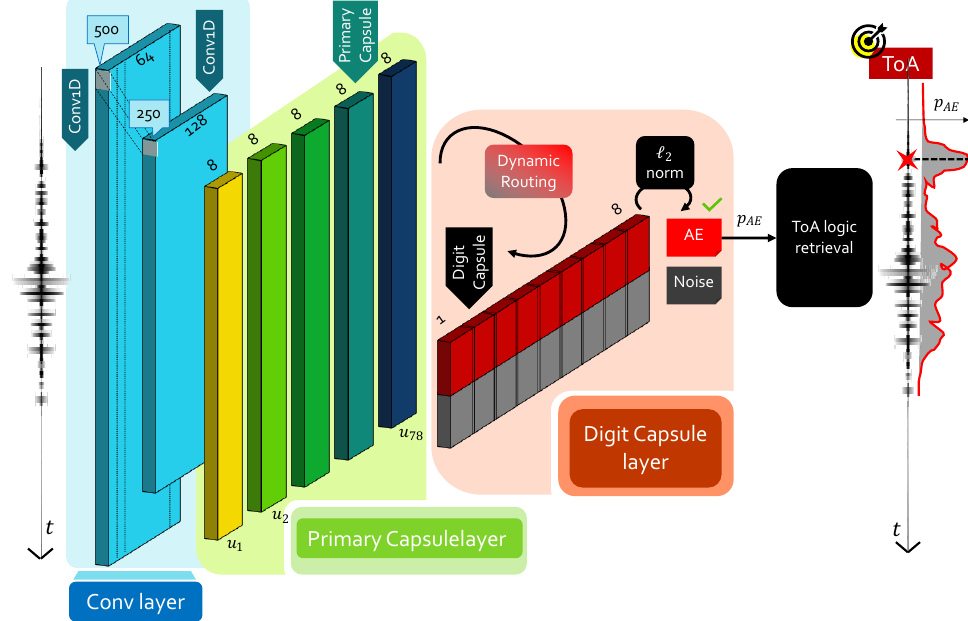
Figure 4. Proposed CapsNetToA architecture for ToA